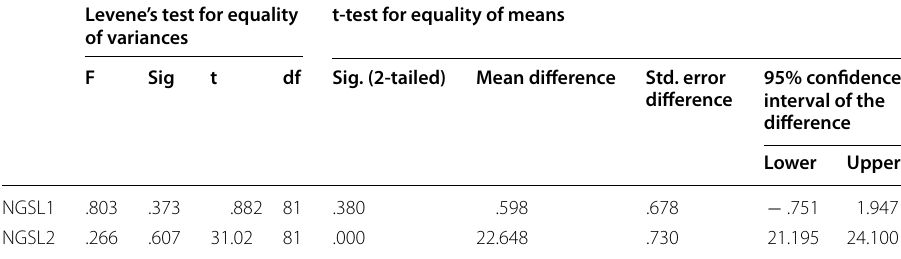
t-test for equality of means